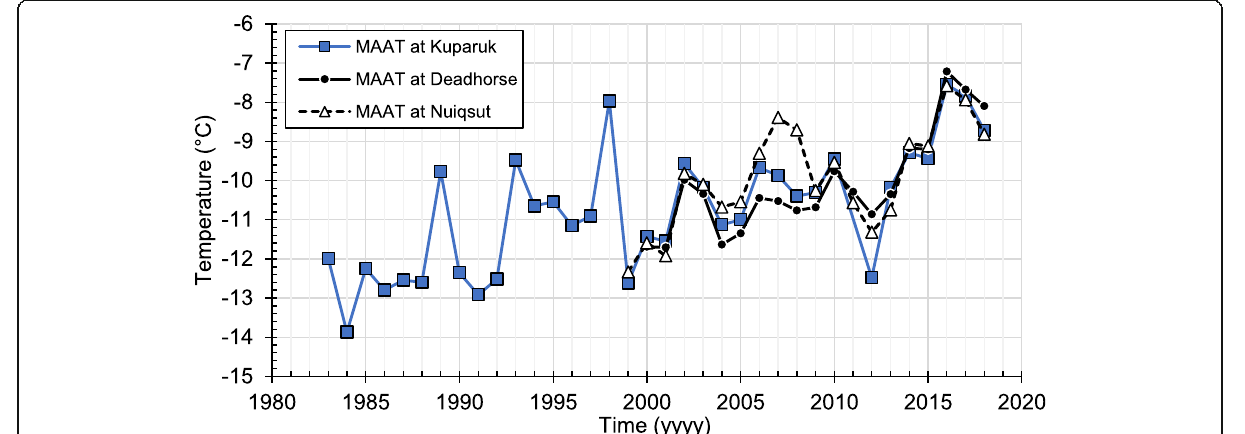
Fig. 2 Mean annual air temperature comparison between locations indicating similar increasing temperature